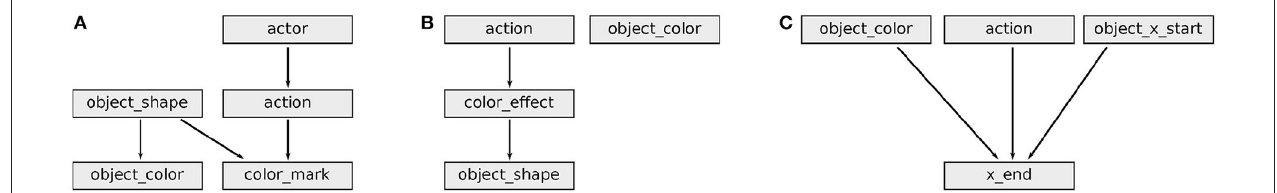
FIGURE 8 | Learned Bayesian networks for the experiments. (A) (actor, action) equivalence between Baxter and Katana actors using different movements to reveal a colored region of interest (section 3.5.1). The BN shows the dependence between the chosen actors and actions and the revelation of the colored region of interest. (B) (object) equivalence between two dusters of different colors that clean a whiteboard (section 3.5.2). The BN shows the irrelevance of object_color feature for the wiping affordance. (C) (action) equivalence between push/pull actions (section 3.5.3). The BN shows the relation between the chosen action and the final displacement of the object (feature